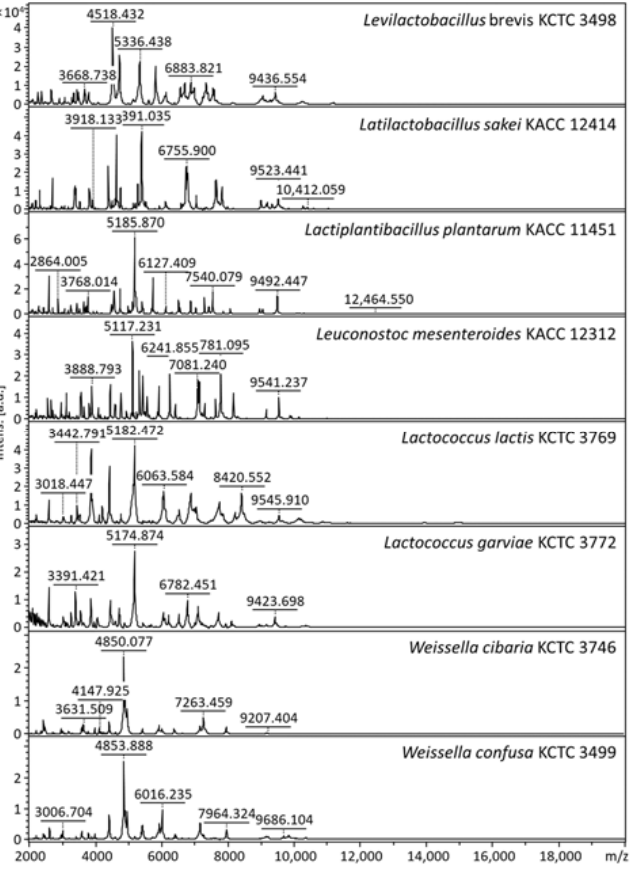
Figure 3. Changes in viable cell count of kimchi samples during the fermentation period at different temperatures.